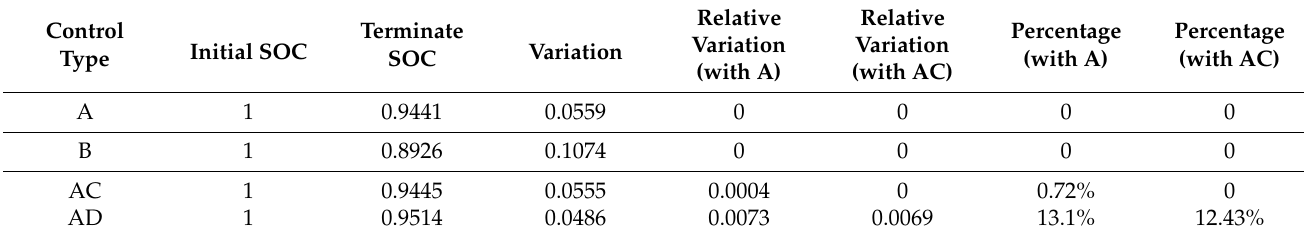
Figure 8. Variation of the battery SOC with a single power supply. Table 1. SOC changes under different control